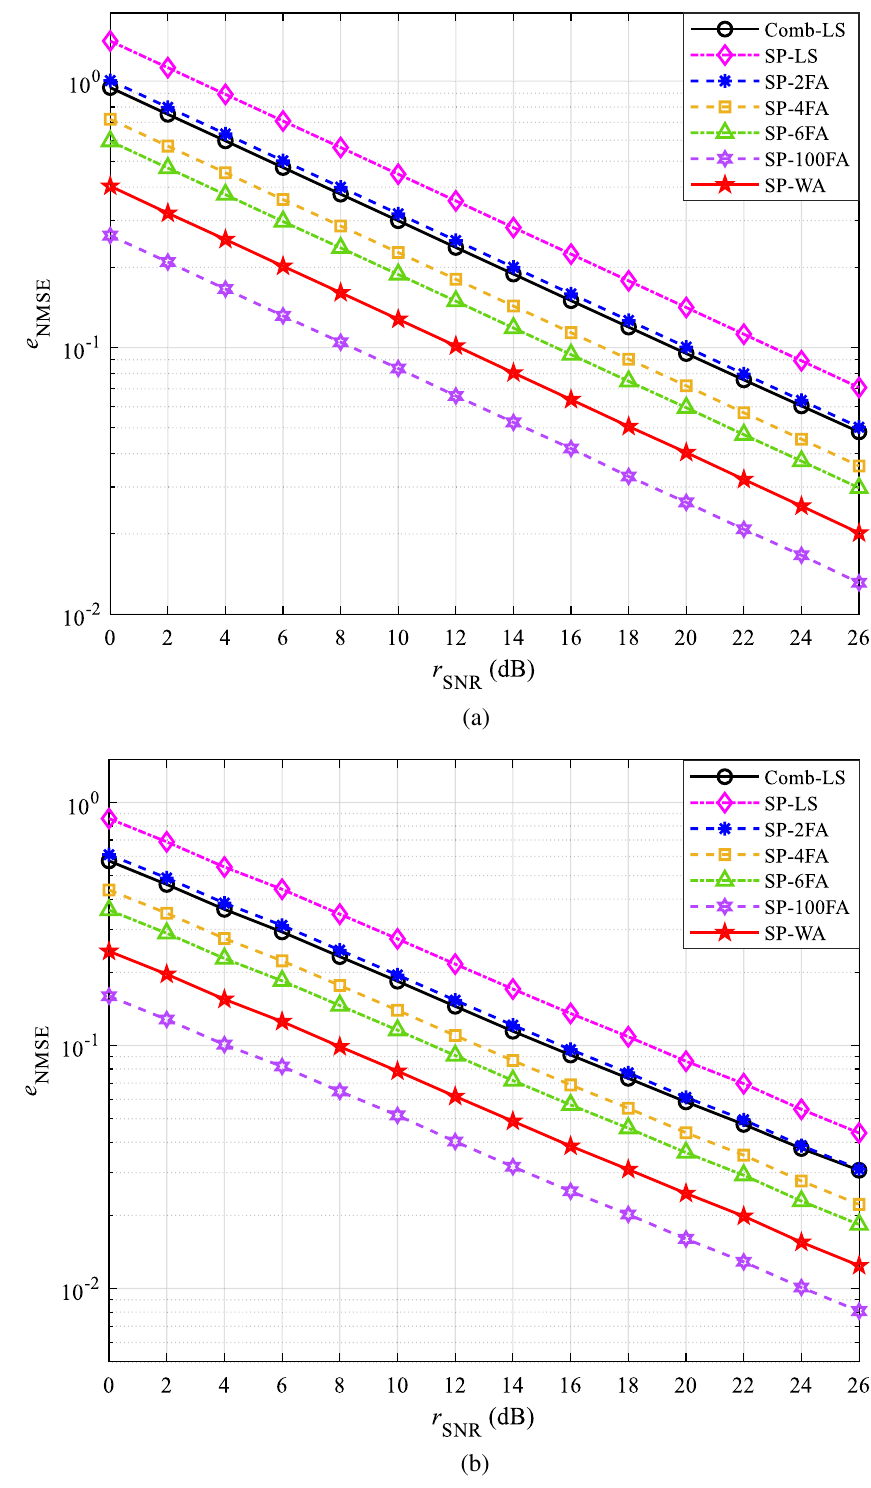
Figure 5. The NMSE performance in CDT 1 channel: ( a ) QPSK and ( b )